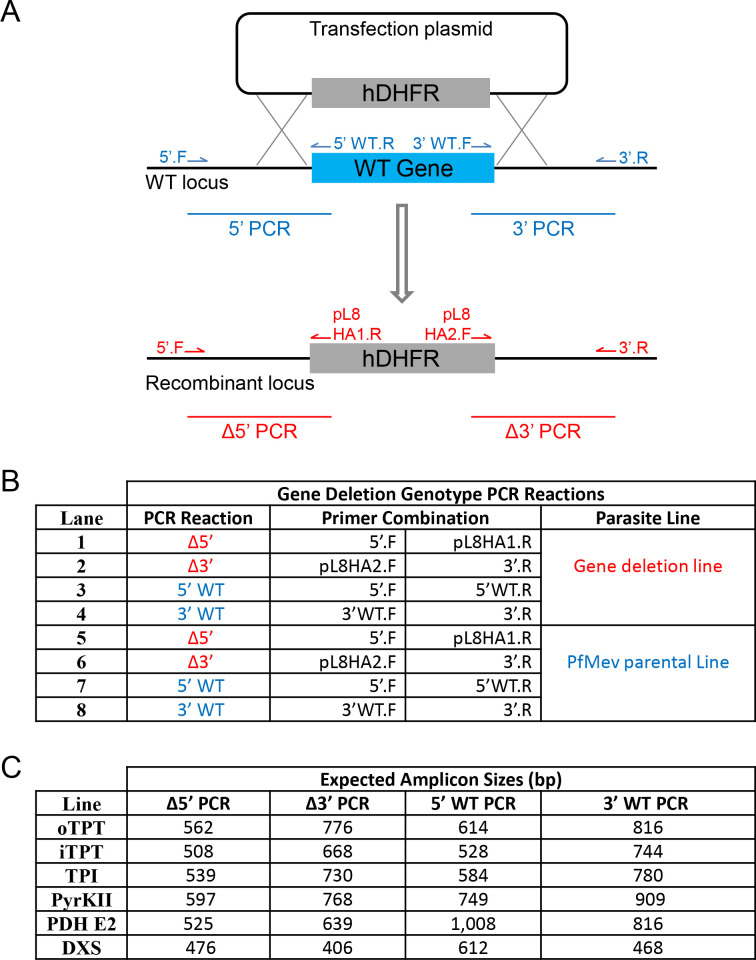
Schematic and details describing gene deletion experiments.(A) Schematic representation showing how targeted genes (WT Gene) were replaced with the hDHFR drug resistance cassette. The positions of genotyping PCR products designed to identify the wild-type locus (blue) or the recombinant locus (red) are show. (B) Table demonstrating how diagnostic primers were used to validate the genotypes of knockout parasite lines. (C) Table showing the expected amplicon sizes for the genotype PCR reactions shown in Figures 2A, 3A and 4A.